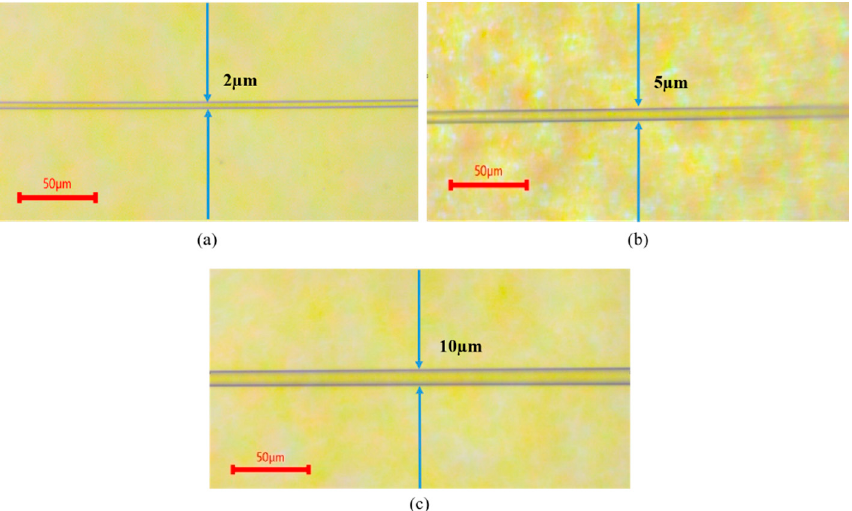
Figure 3. Microscopic image for tapered region MF with 2 µm ( a ), 5 µm ( b ), and 10 µm ( c ) diameter.